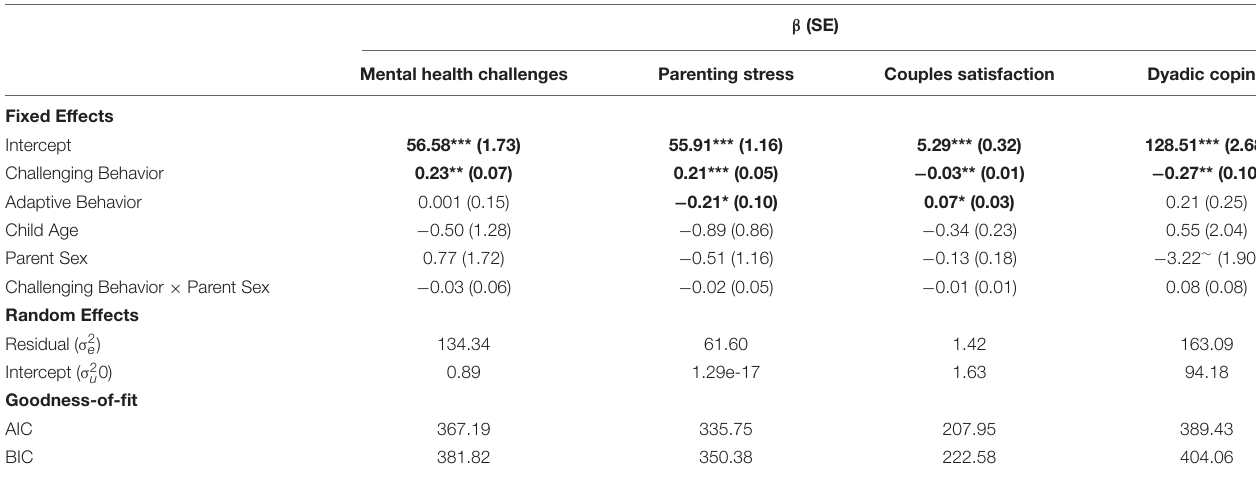
TABLE 13 | Multilevel model results for Aim 4 ( n =